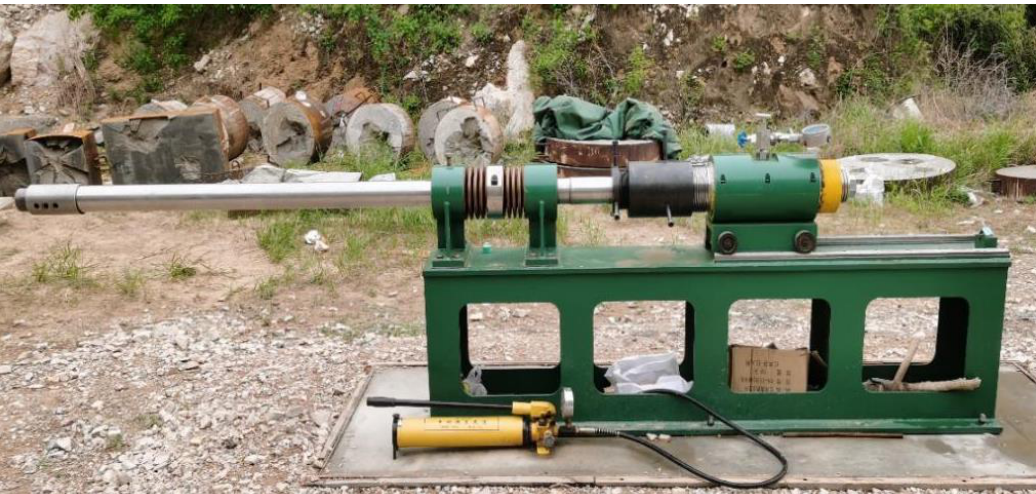
Figure 5. A 40 － caliber one － stage hydrogen － driven gas gun. Figure 5. A 40-caliber one-stage hydrogen-driven gas